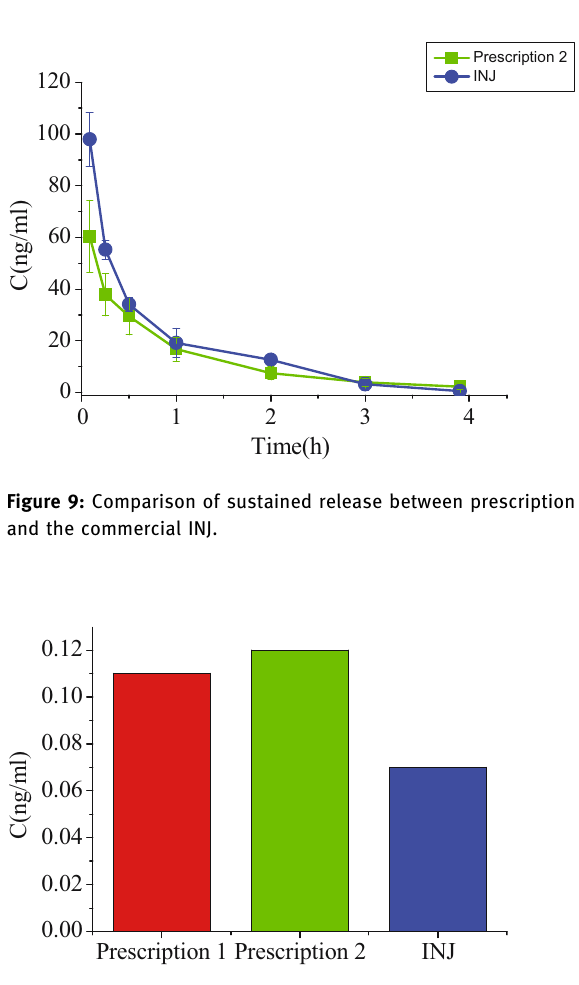
Figure 10: GB concentration in brain